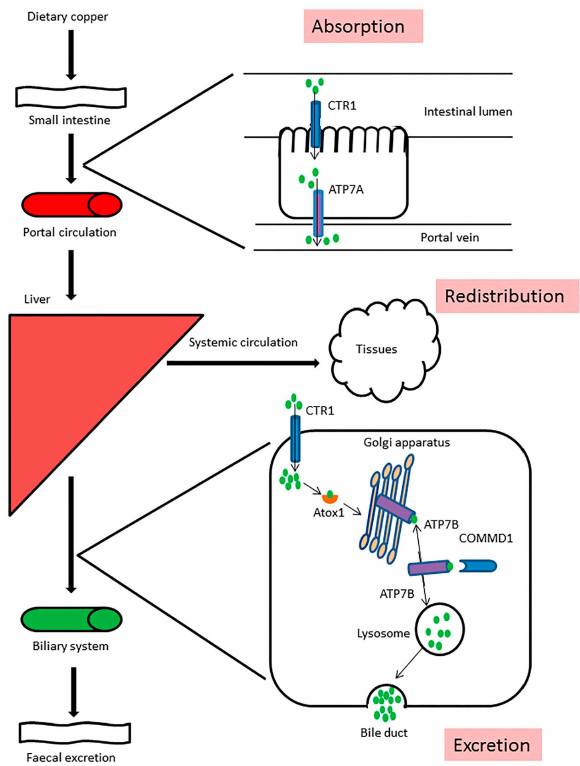
Figure 1. Dietary copper is absorbed in the small intestine via Ctr1. ATP7A facilitates copper transport from the enterocyte into the portal circulation for transportation to the liver. In the liver, copper is imported in the enterocytes by Ctr1. Here, copper is stored or redistributed via the systemic circulation for use in body tissues. Excretion of excess copper from hepatocytes takes place via copper transporter ATP7B. ATP7B resides in the trans-Golgi network under low copper conditions. It receives copper molecules from the chaperone ATOX1 and under high copper conditions it moves to a late endosome/lysosome compartment, from which copper is eventually excreted in the bile and expelled from the body with the feces. COMMD1 is believed to interact with ATP7B and to facilitate retrograde trafficking of ATP7B back to the trans-Golgi